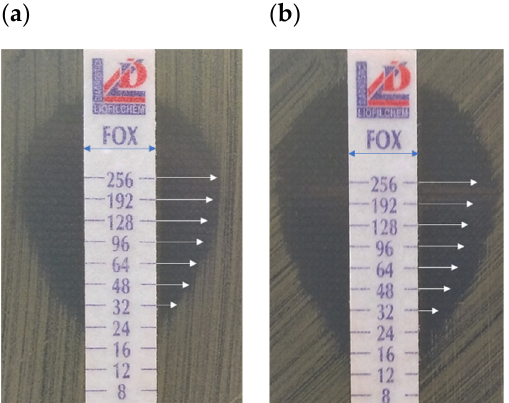
Figure 4. Representative pictures of growth inhibition zones around E-test strips with cefoxitin in ( a ) control and ( b ) RMF-exposed (5 Hz) S. aureus ATCC 33591 cultures. The arrows at a certain antibiotic concentration represent sections of the same length.